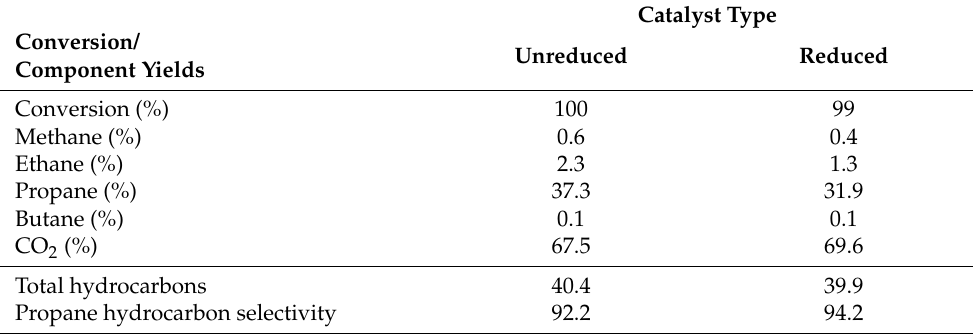
Table 3. Effect of catalyst reduction on the butyric acid conversion and gas product yields.